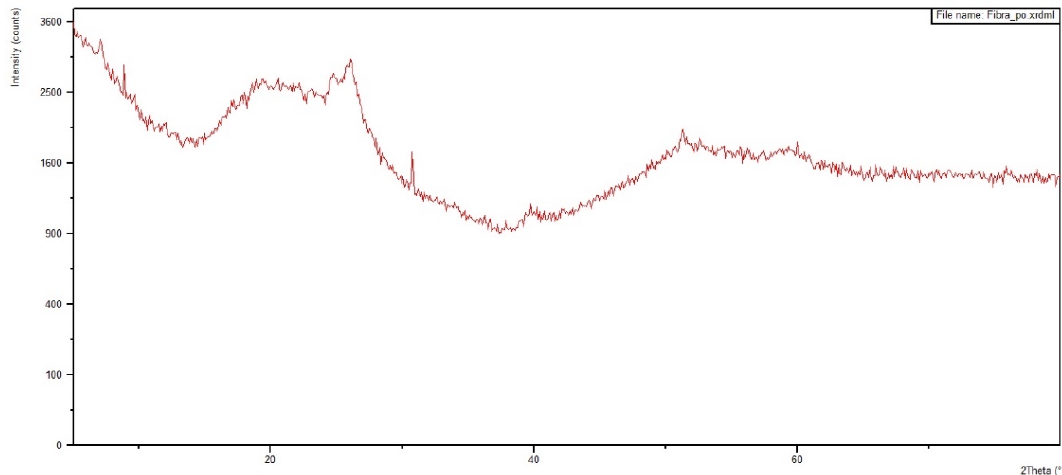
Figure 11. FTIR spectrum obtained for the 30 vol% ramie fabric-reinforced GO-incorporated epoxy composite.